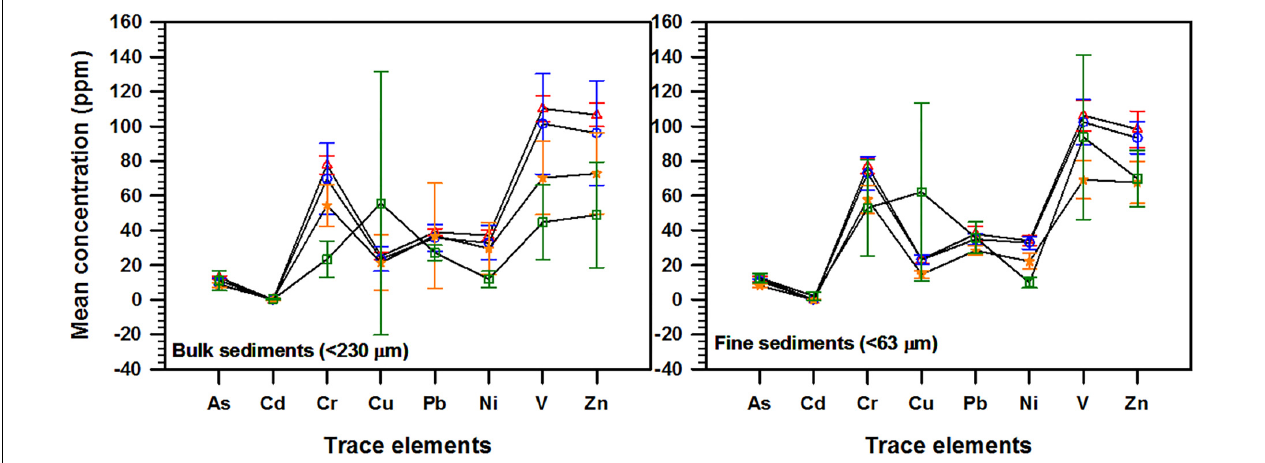
FIGURE 6 | Transect-wise (A–D) mean ( ± SD) concentrations trace elements in bulk ( < 230 µ m) and fine ( < 63 µ m) sediments investigated from off northwest Hainan Island, the Gulf of Tonkin, illustrating spatial variabilities. Note the odd trend of samples from transect D due to the riverine influence with heavy mineral dominance.